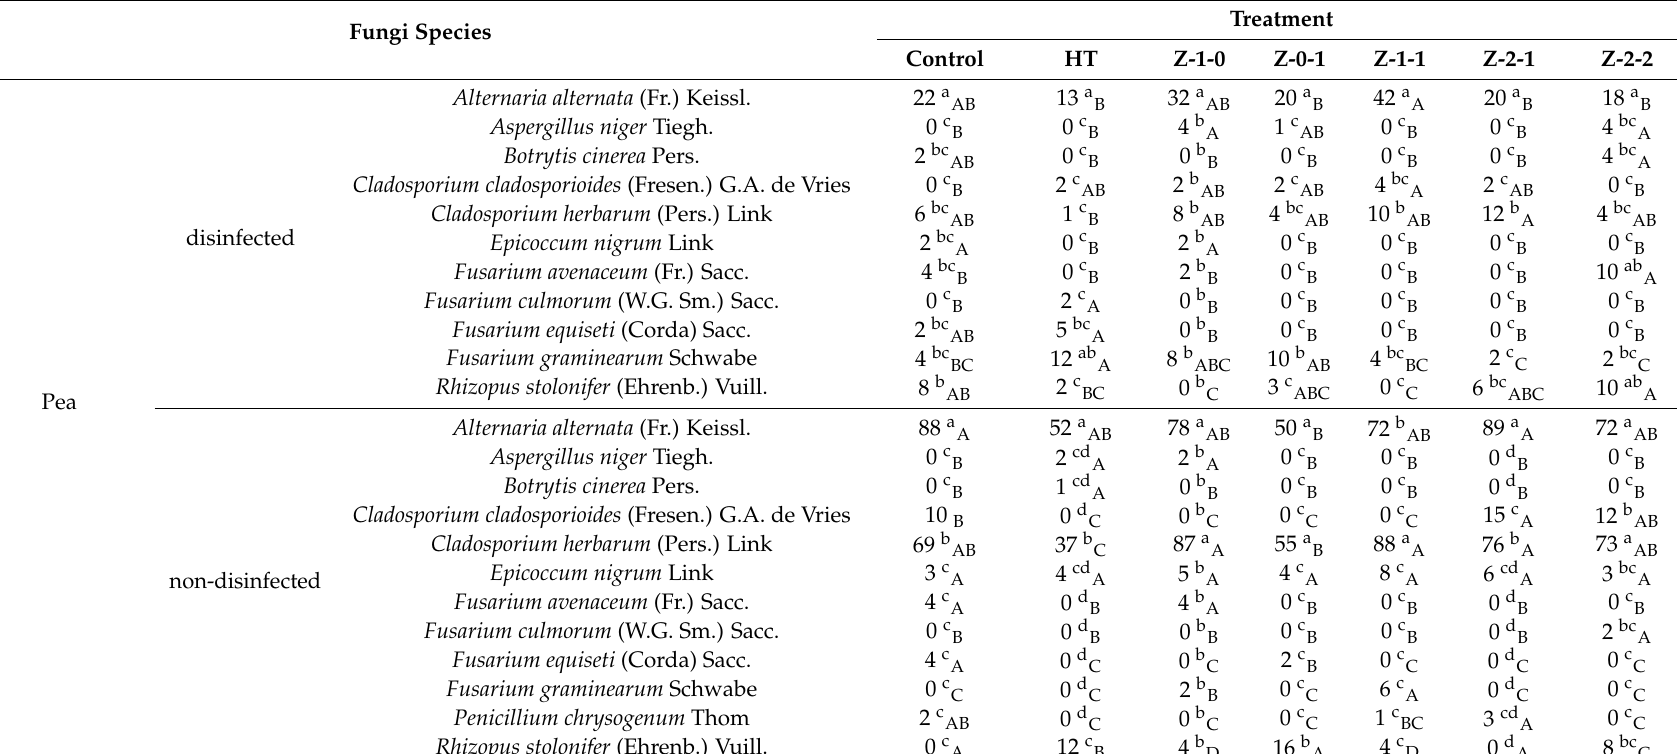
Table A2. Cont. Treatment Fungi Species Control HT Z-1-0 Z-0-1 Z-2-2 Alternaria alternata (Fr.) Keissl. 22 a AB Aspergillus niger Tiegh. 0 c B Botrytis cinerea Pers. Cladosporium cladosporioides (Fresen.) G.A. de Vries Cladosporium herbarum (Pers.) Link